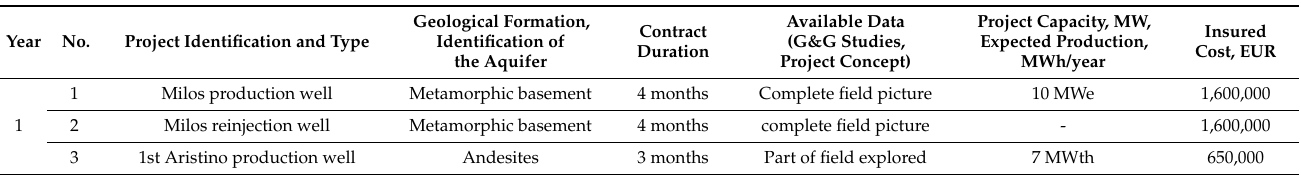
Table A2. Characteristics and assumptions concerning the development of geothermal